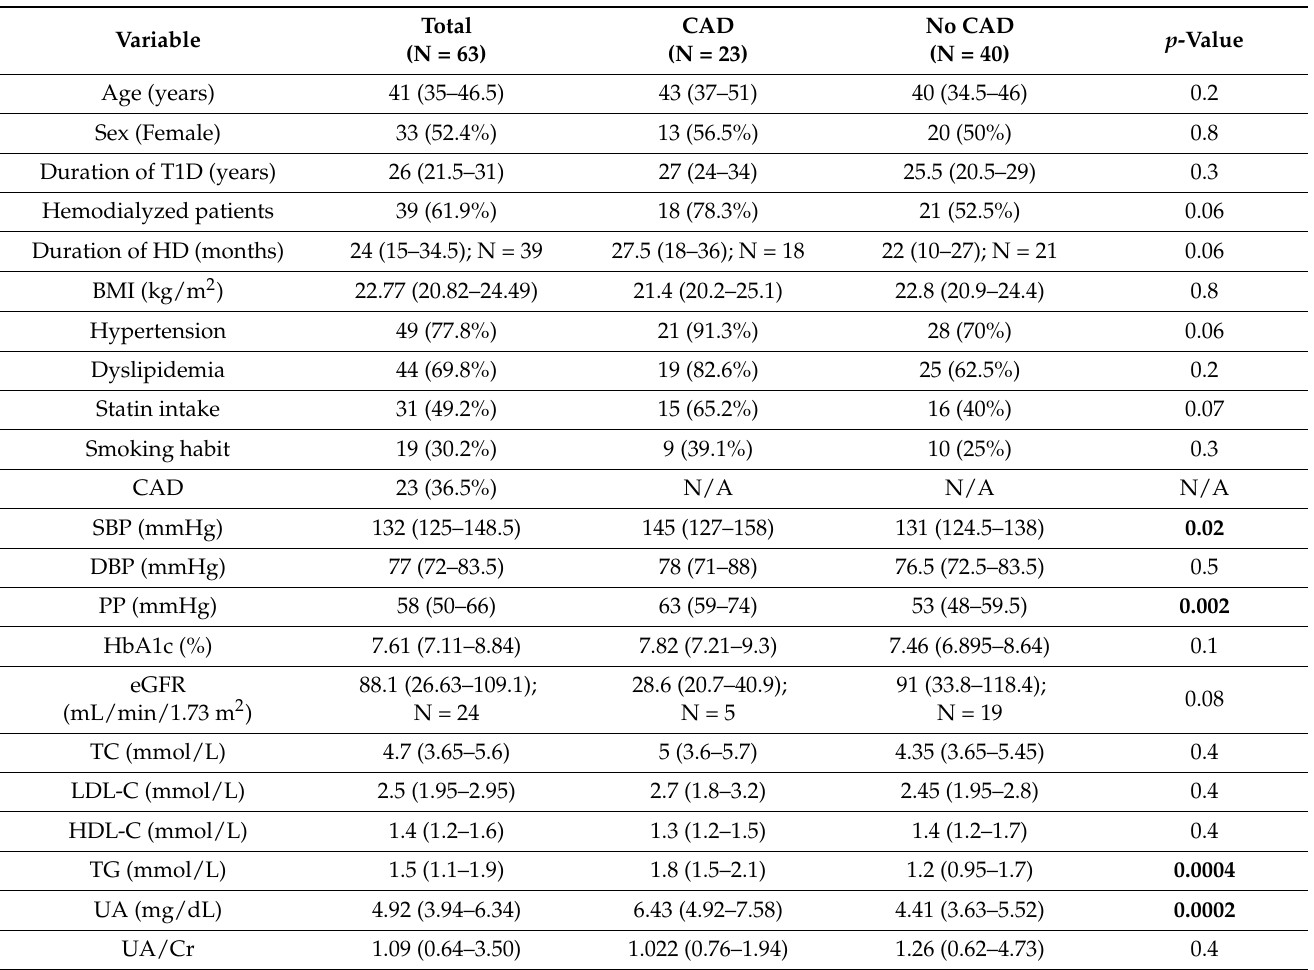
Table 3. Characteristics of the study group stratified by presence/absence of coronary artery